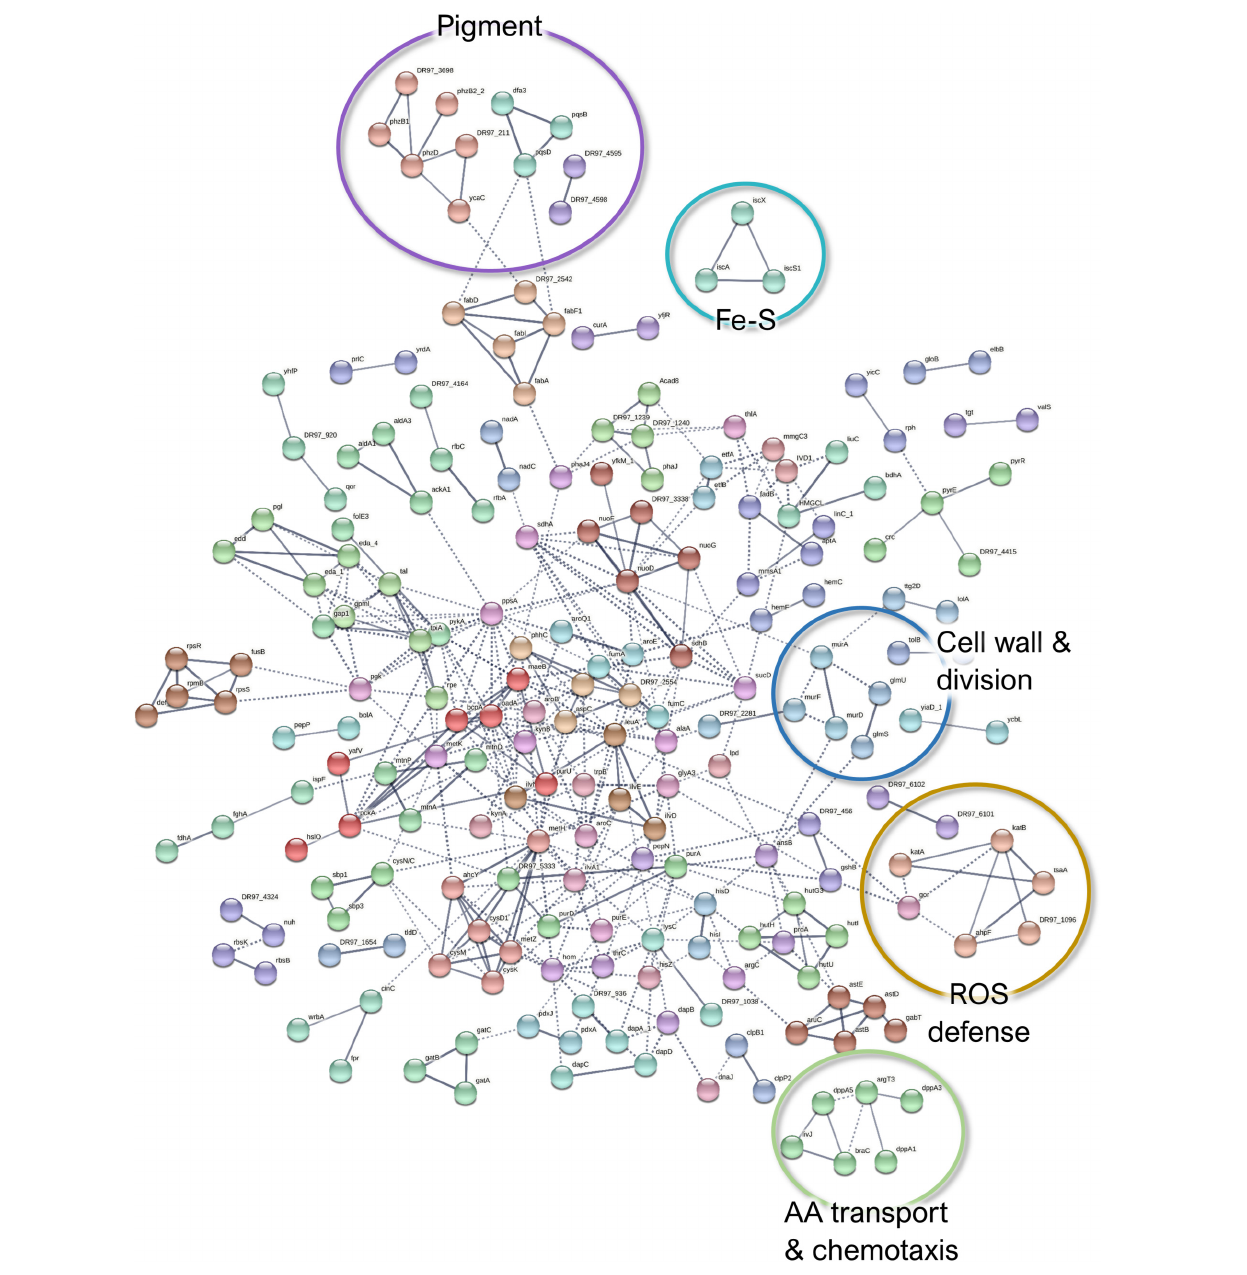
FIGURE 7 | A STRING database (Szklarczyk et al., 2019) network of interacting proteins with a significantly lower abundance in Pseudomonas aeruginosa co-culture versus monoculture exoproteome. Due to the large number of interactors, only high-confidence interactions are